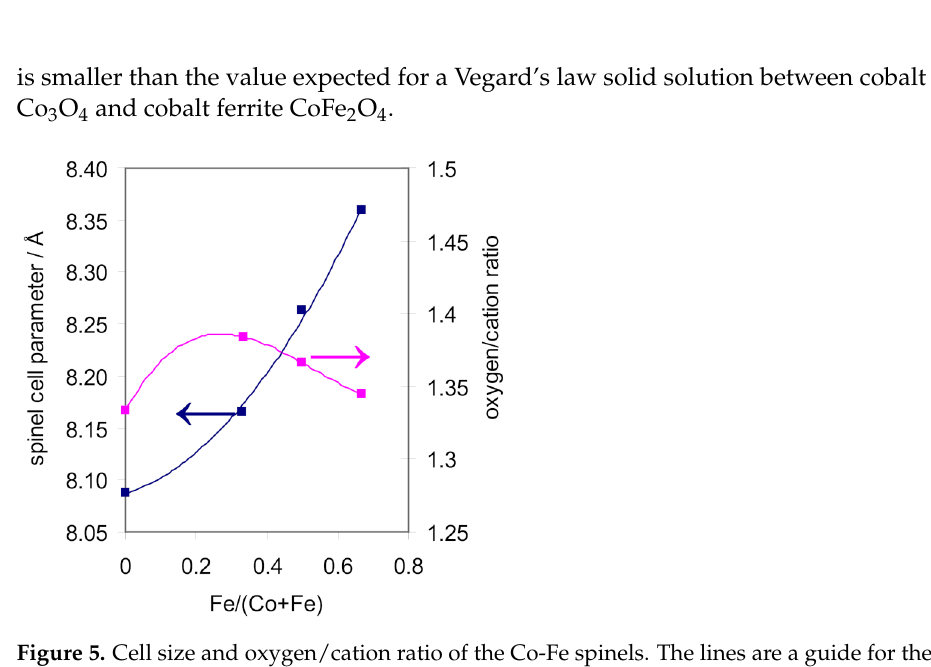
Figure 5. Cell size and oxygen/cation ratio of the Co-Fe spinels. The lines are a guide for the eyes.